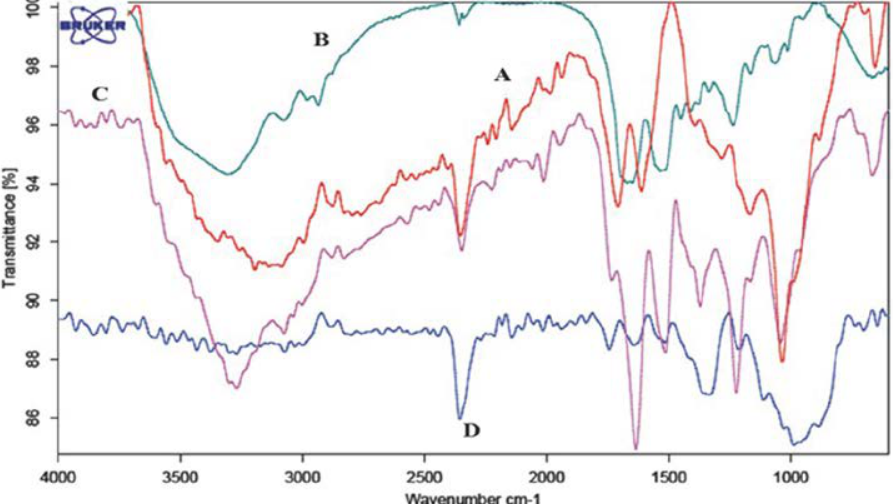
Figure 2. FT-IR spectrum of A) GO, B) SF, C) SF/GO composite and D)